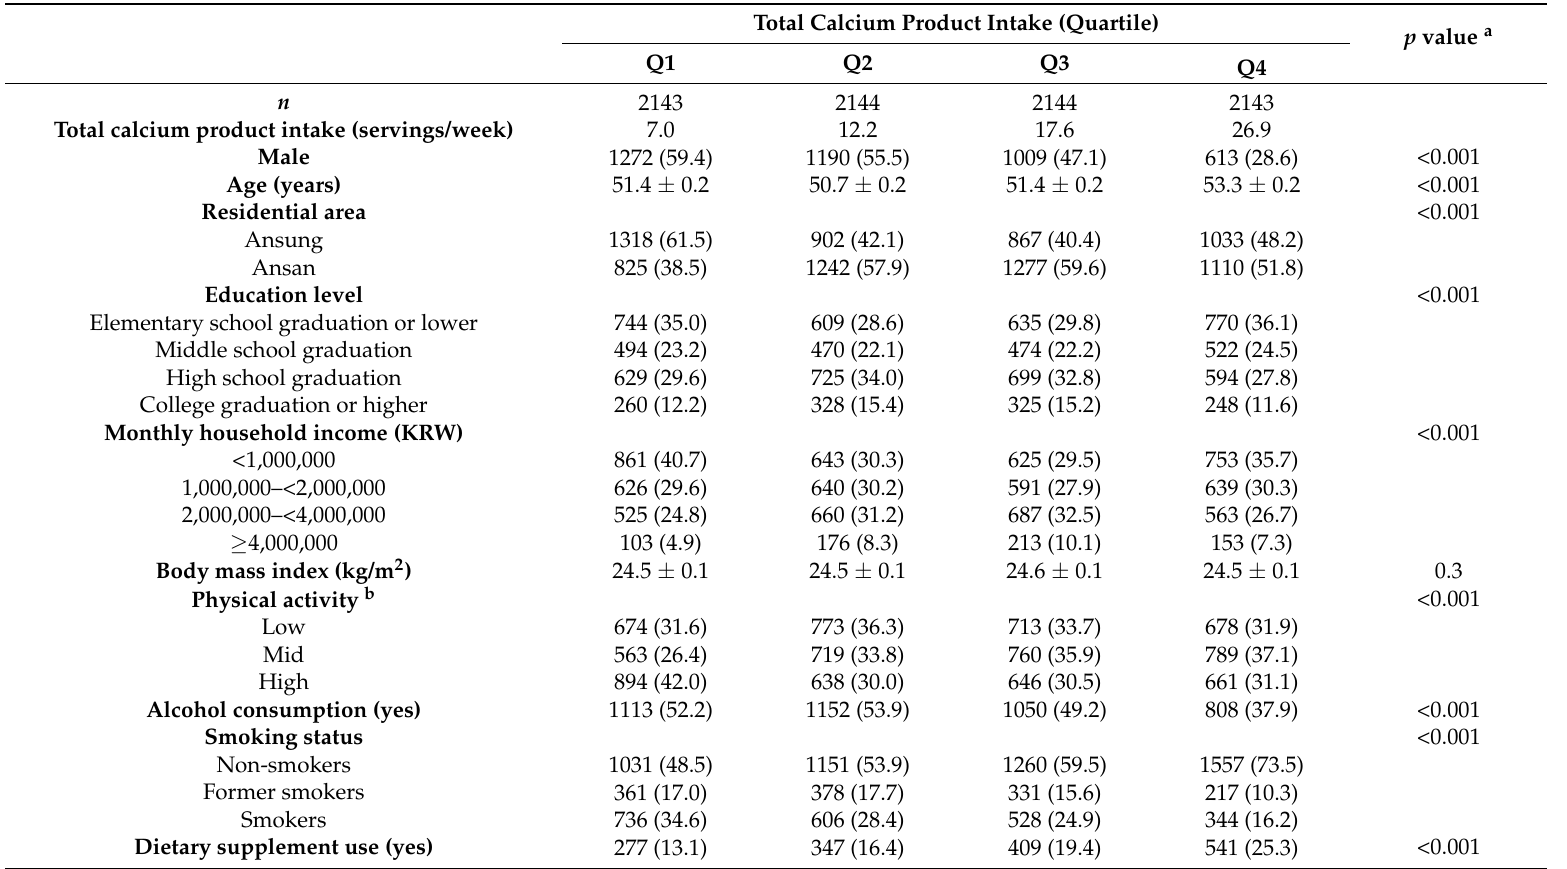
Table 1. Baseline characteristics of participants according to quartiles (Q) of energy-adjusted total calcium product